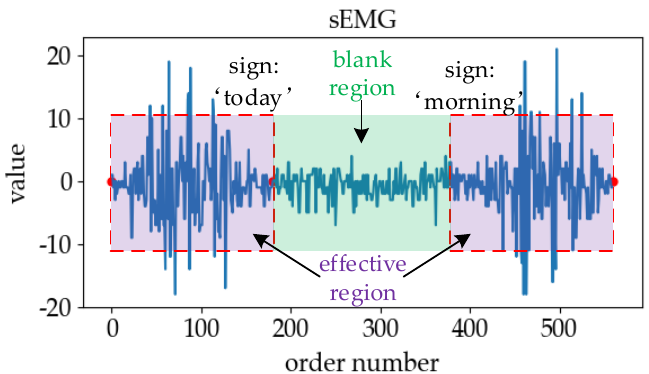
Figure 1. A segment of surface electromyography (sEMG) signal containing two effective regions and one blank region. The purple area in the red box represents the effective region of sign language action, while the green area represents the blank region. The left box represents the sign language of “today” and the right box is “ morning ” .